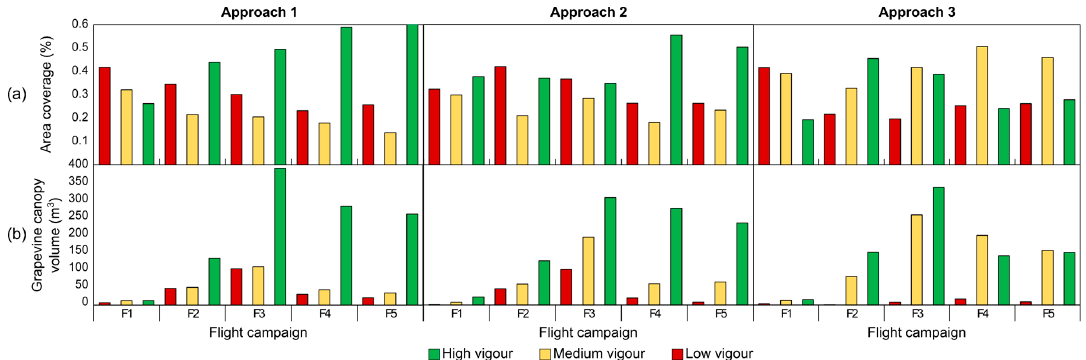
Figure 8. Vineyard area ( a ) and grapevines’ canopy volume ( b ) per vigour class and approach in all flight campaigns (F#).